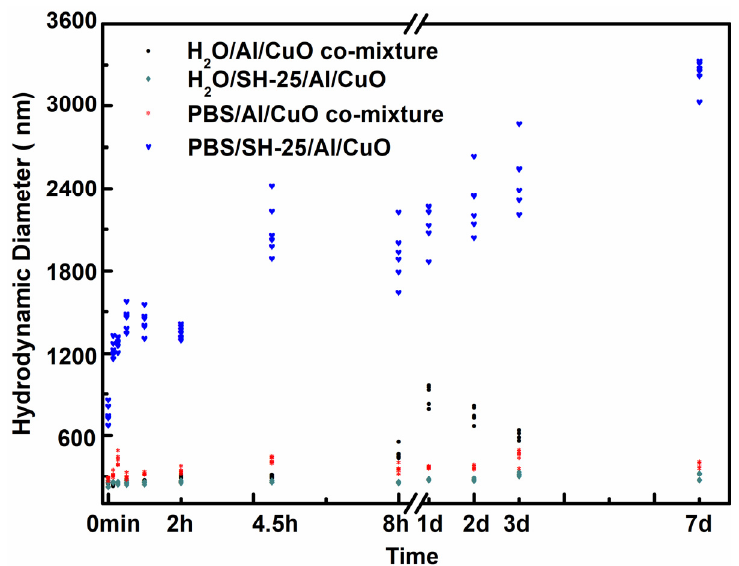
Figure 5. Impact of assembly time on the hydrodynamic diameter. The red dots depict the PBS/Al/CuO comixture. The blue dots denote the PBS/SH-25/Al/CuO. The black dots represent the H 2 O/Al/CuO comixture (owing to the oxidation of Al NPs and the substantial change in particle size, the hydrodynamic diameter was not given on the 7th day). The cyan dots represent H 2 O/SH-25/Al/CuO.